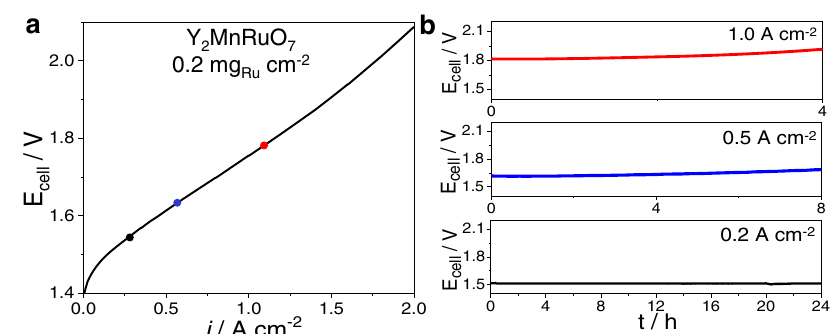
Fig. 7 | PEMWE measurements with Y 2 MnRuO 7 anode (0.2mg Ru cm − 2 ). a Cell potential(E cell )asafunctionofthecurrentdensity( j )recordedgalvanostaticallyup